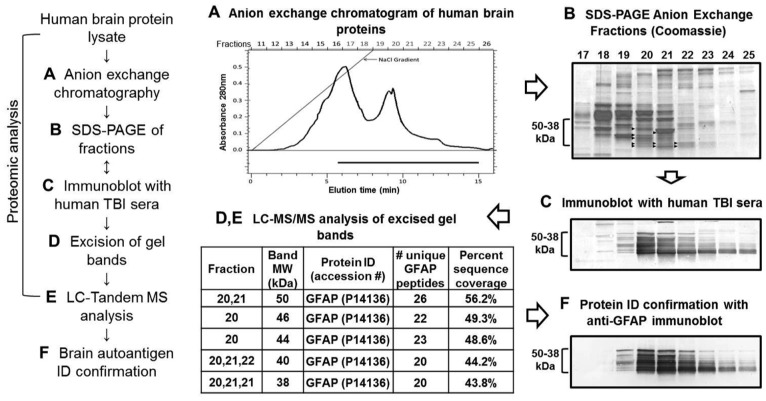
A proteomics approach identified GFAP as the predominant TBI-associated autoantigen.Workflow of the proteomic analysis is shown at left. A. Human brain lysate was subjected to anion-based chromatographic separation. A graph of absorbance at 280 nm of fractions 11–26 with elution time is shown. B. Fractions were subjected to SDS-PAGE separation, and gels were stained with Coomassie blue to visualize proteins (fractions 17–25 are shown). C. Duplicate gels were blotted and probed with pooled TBI sera (Day 10; n = 4). D, E. The Coomassie gels in B were overlaid by TBI blots in C, immunoreactive bands from fractions 20–22 were excised for LC-MS/MS analysis (arrowheads), and results are shown in the table. F. A duplicate blot to that in C was probed with anti-GFAP antibody (Abcam) to confirm that GFAP was the autoantigen.